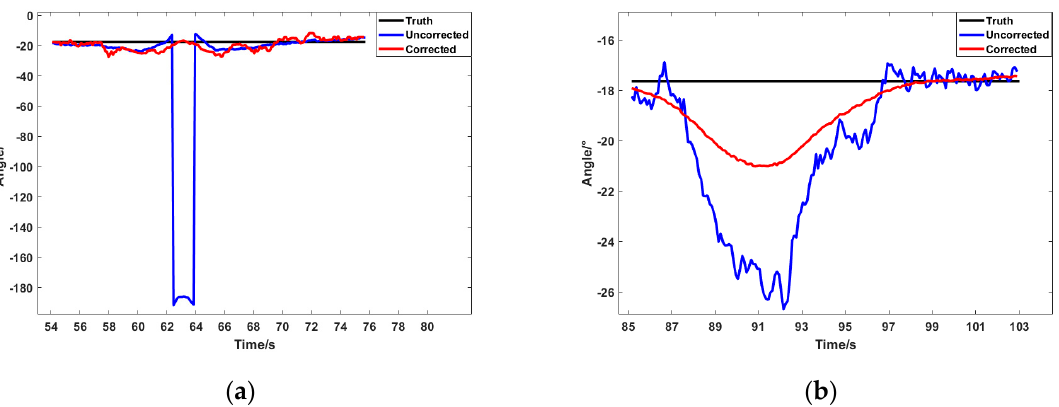
Figure 12. Output of triaxial magnetometer: ( a ) triaxial magnetic field data under large interference; and ( b ) triaxial magnetic field data under small interference.